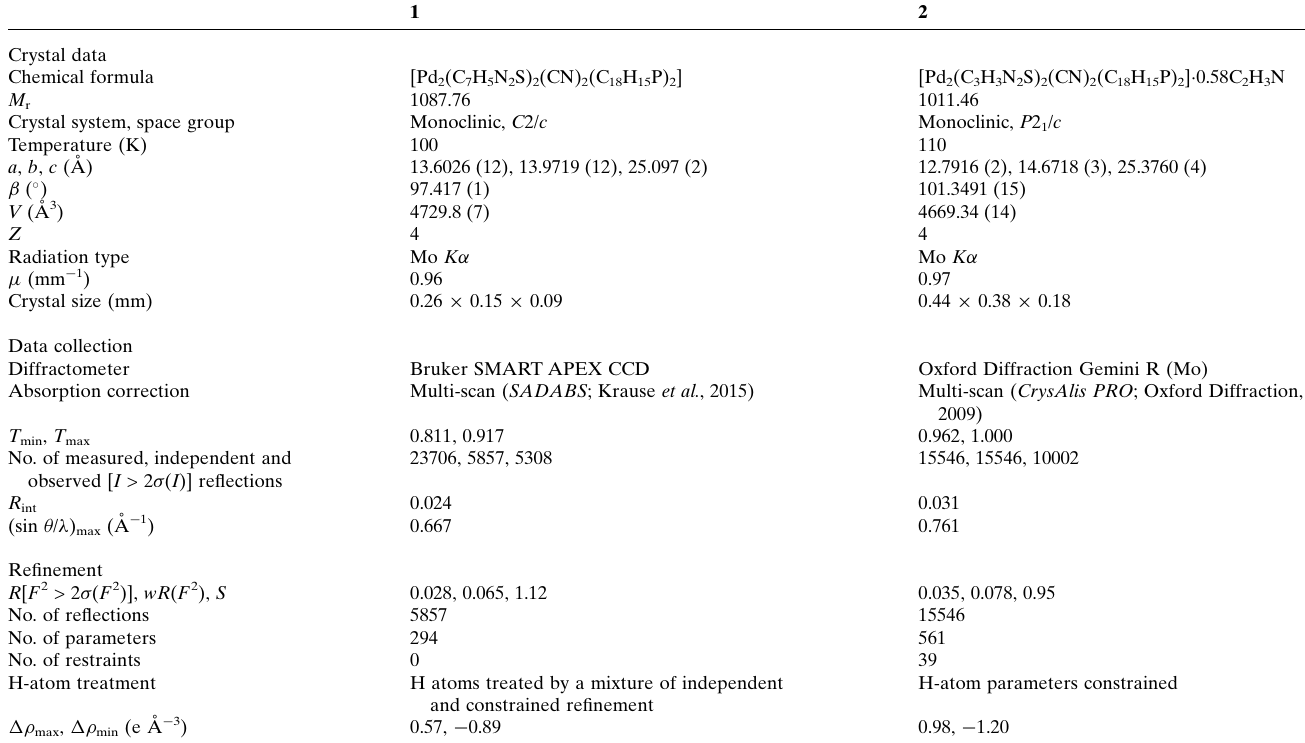
Table 5 Experimental details.